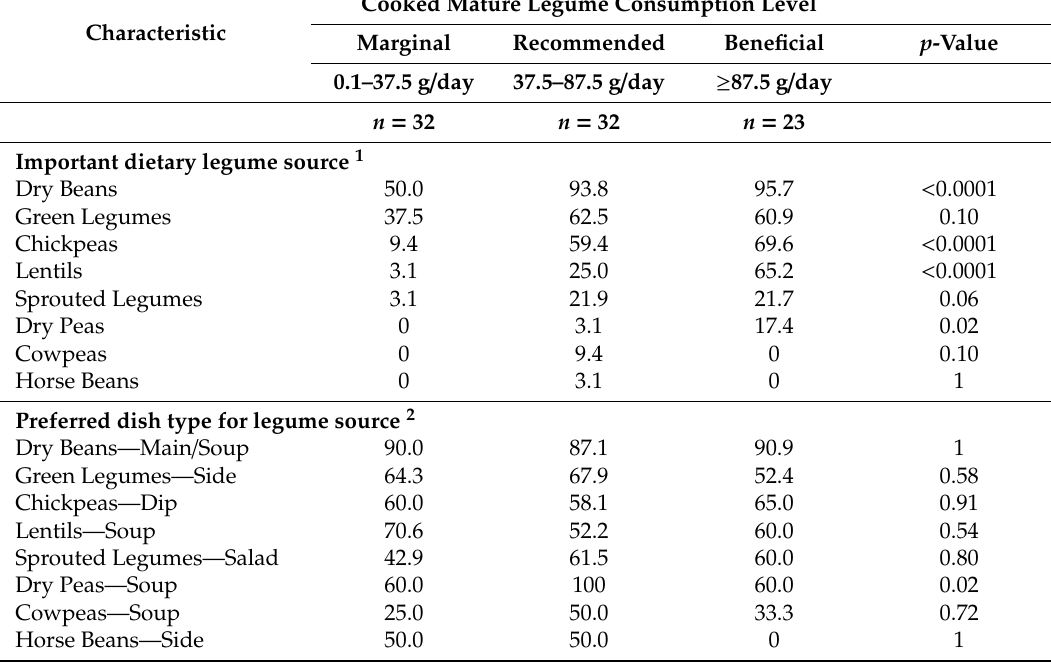
Table 6. Legume consumption patterns among mature-legume consumers stratified by dietary recommendations for cooked mature legume consumption (37.5 g / day) and amounts demonstrating nutritional and disease prevention benefits (87.5 g / day): Beans, Lentils, Peas Nutrition Education Online Parent Survey